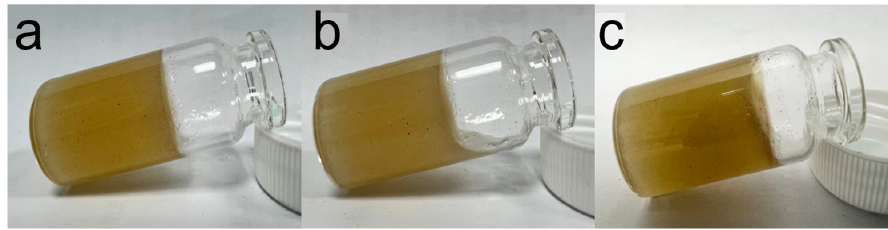
Table 1. Feed ratio scheme for formulating IPN (KGM/NIPAM) hydrogel.